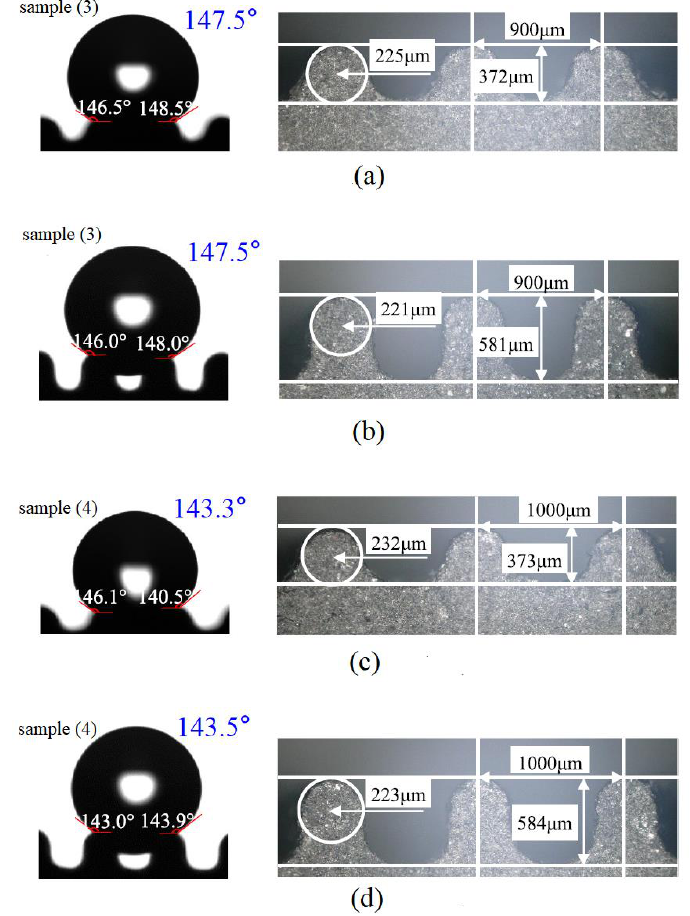
Figure 11. Relationship between designed parameters of the groove and the contact state [25]. ( a ) The original sample (3); ( b ) the sample (3) with deep groove; ( c ) the original sample (4); ( d ) the sample (4) with deep groove. Table 2. Summary of the process of EDM described in the text grouped by machining type and object fabricated.